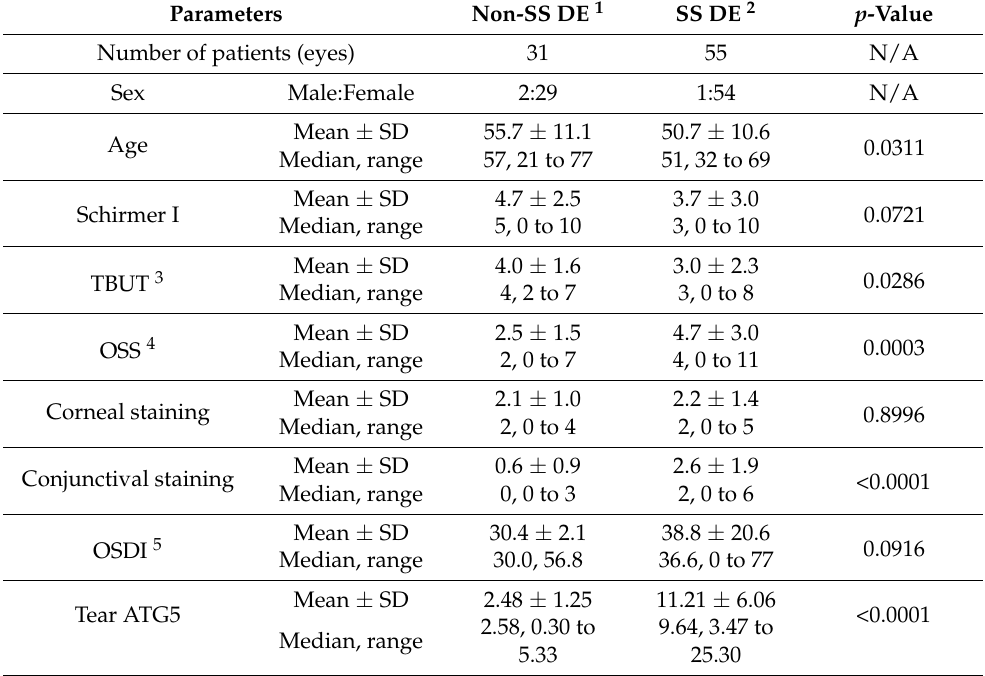
Table 1. Comparison of descriptive data between Sjögren syndrome (SS) and non-Sjögren syndrome dry eye (DE) disease